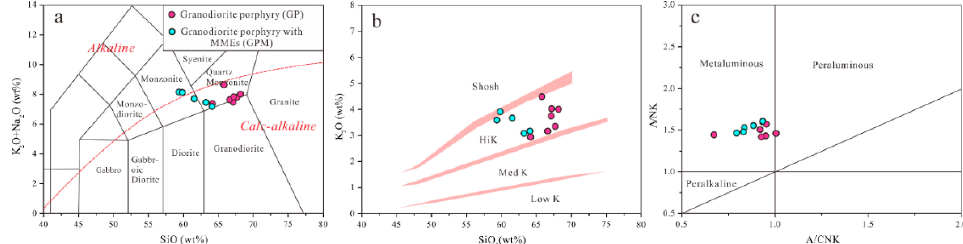
Figure 5. Classification diagrams of the lithochemical compositions for the Qiaomaishan intrusions. ( a ) Total alkalis vs. silica (TAS) [27], ( b ) plot of K 2 O–SiO 2 [28], ( c ) A / NK versus A / CNK diagram for the